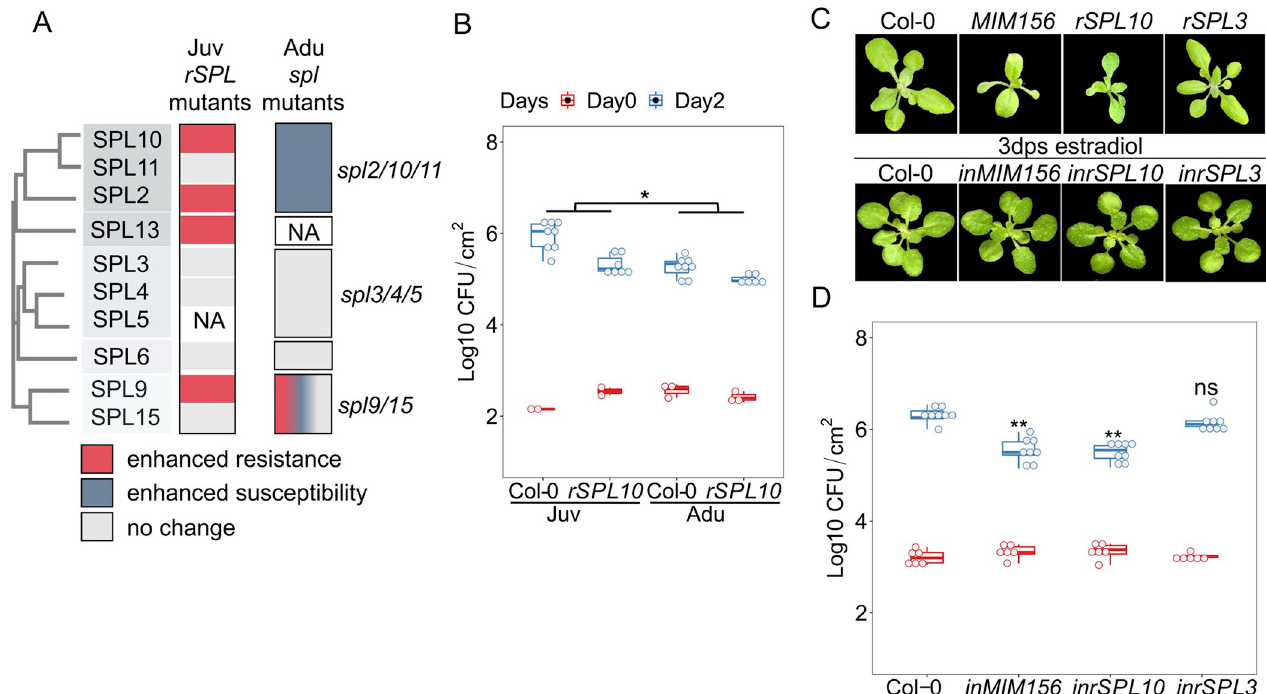
Fig 2. MiR156-targeted SPL10 promoted resistance to Pto DC3000. A , disease phenotype of Pto DC3000 in SPL gain and loss-of function mutants. NA, not available. B , bacterial growth in leaves 1–2 and leaves 11 from Col-0 and rSPL10 . C , developmental phenotype of Col-0, and early phase change phenotypes of transgenic plants expressing stable MIM156 , rSPL10 and rSPL3 on ½ MS plate (top panel); developmental phenotype of Col-0, estradiol-inducible(in)MIM156 , inrSPL10 and inrSPL3 at 3 days after estradiol treatment (bottom panel). D , bacterial growth in leaves 1–2 from 4 -week-old Col-0, inMIM156 , inrSPL10 and inrSPL3 on Day 0 and Day 3. Emmeans package in R was used for statistical analysis in 2 A and 2 B. The student t test was used for statistical analysis in 2 A and 2 C, and each genotype was compared with Col-0 wild type, ns, not significant, � , p < 0.05, �� , p < 0.01. Repeats for the experiments here are shown in